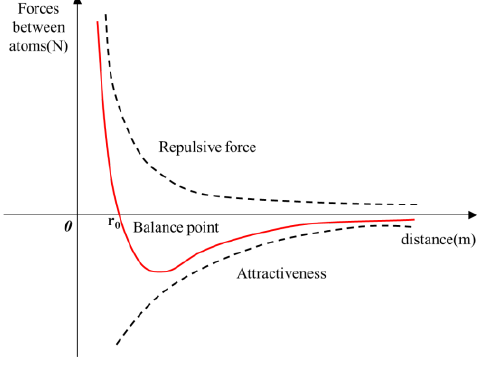
Figure 2. Atomic force-distance curve.